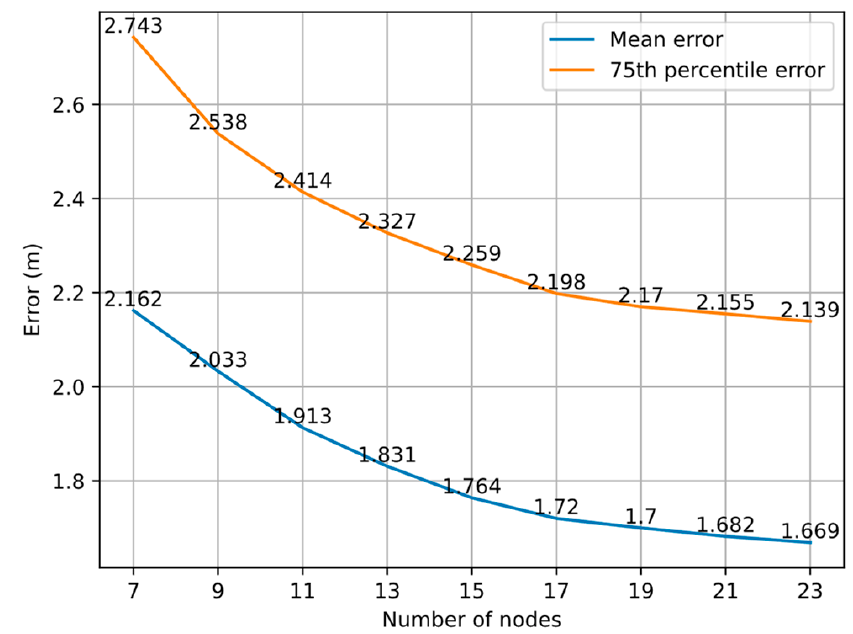
Figure 9. Positioning errors under different numbers of nodes.